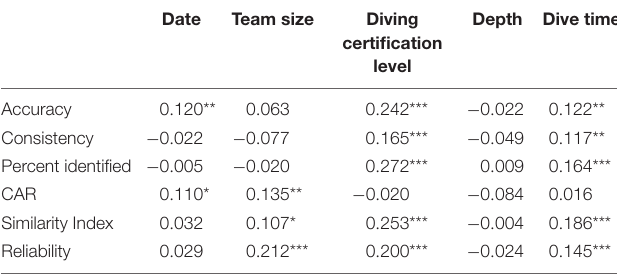
TABLE 2 | Correlations between reliability parameters and independent